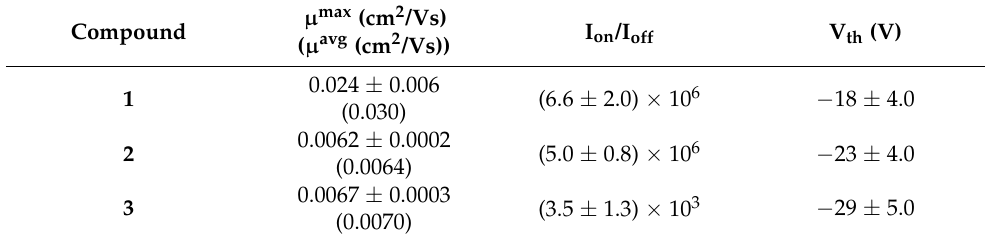
Table 2. OFET device performance based on the thin films of BTBT derivatives. Compound